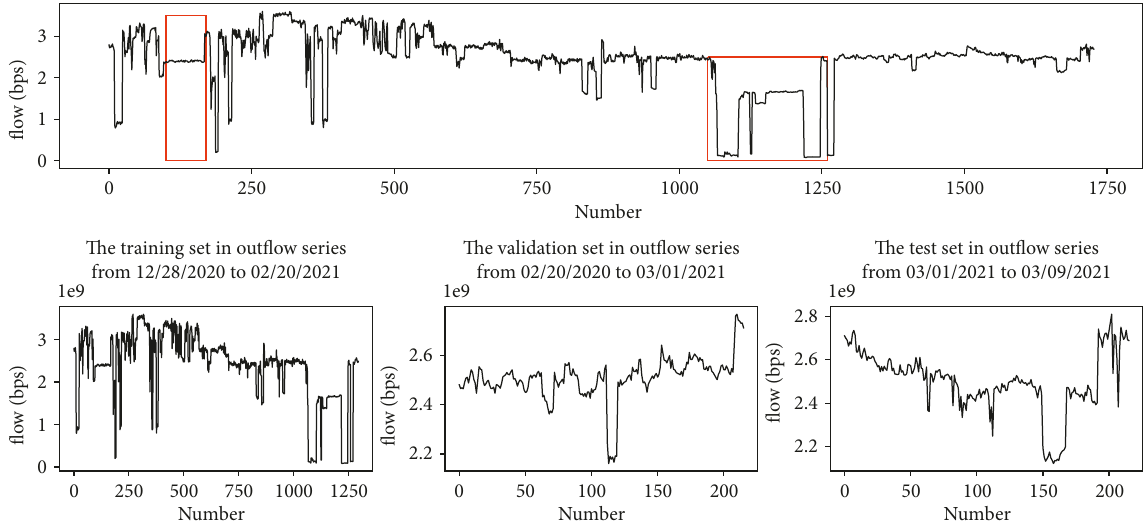
Figure 4: The investigated network outflow flow.